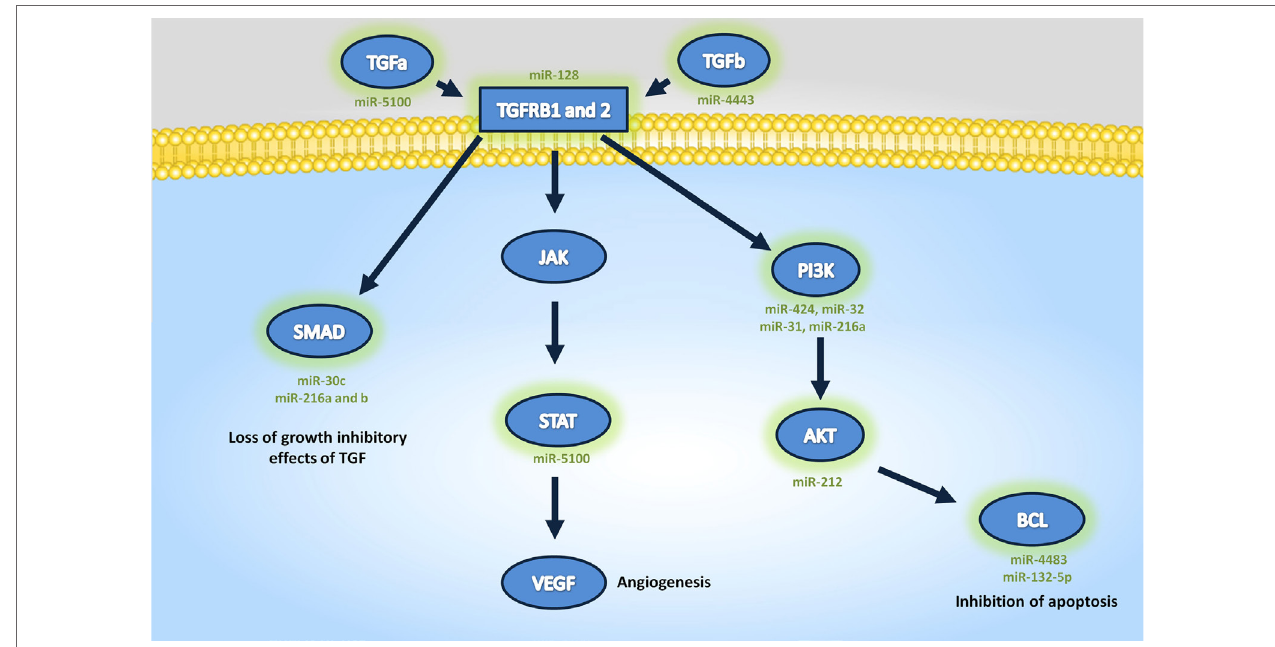
FigUre 1 | Summary of the main target genes targeted regulated